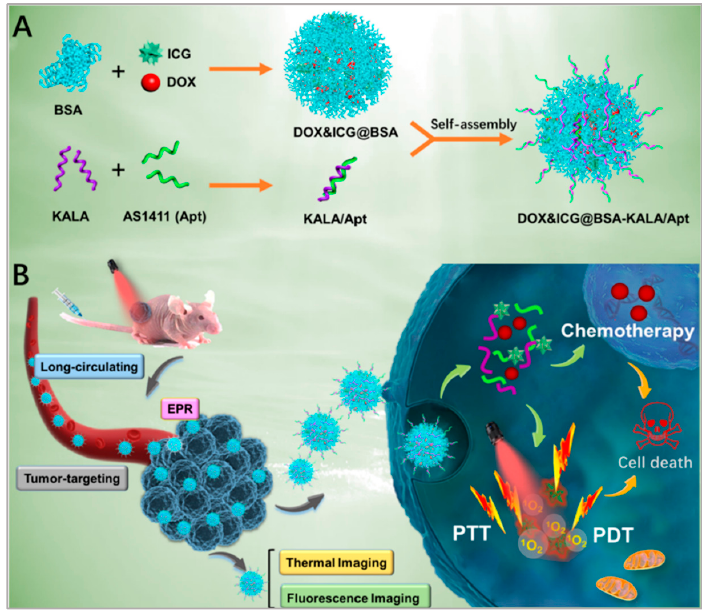
Figure 6. Schematic illustration of: ( A ) the preparation of DOX/ICG/BSA/KALA/Apt nanoparticles; and ( B ) the theranostic process based on DOX/ICG/BSA/KALA/Apt nanoparticles. Reprinted with permission from [92]. Copyright © 2019 American Chemical